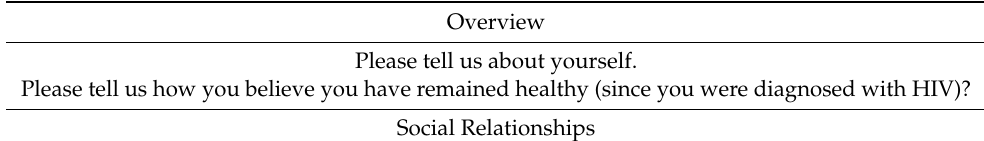
Table 2. Examples of interview guide questions.